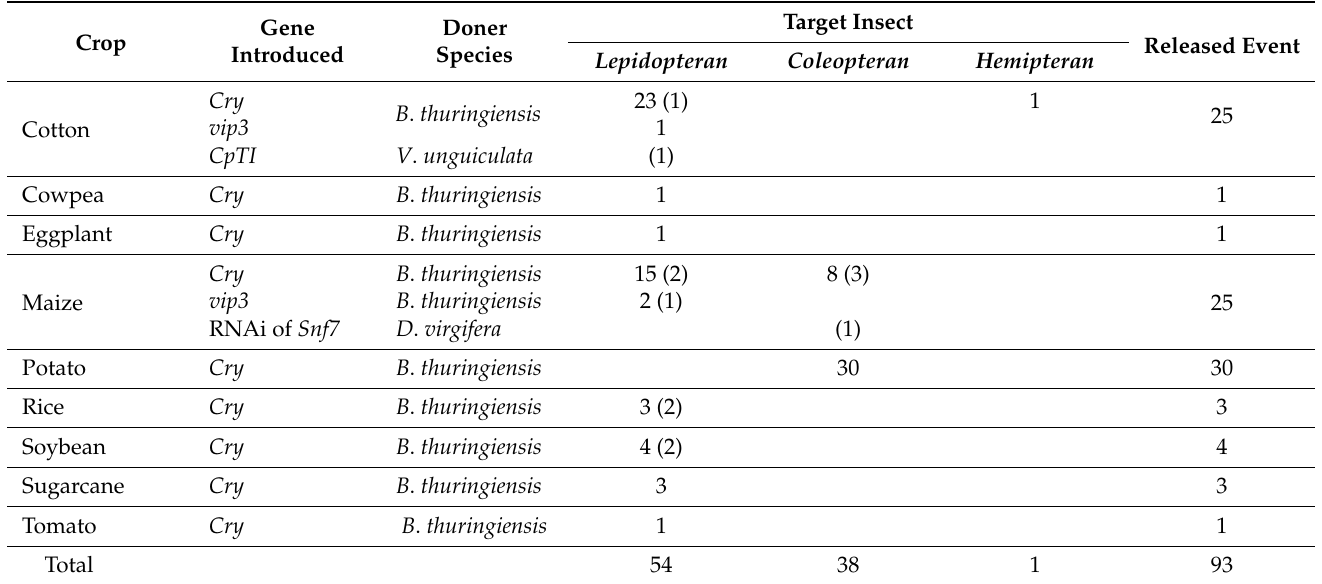
Table 1. Number of transgenic events of insect resistance authorized for cultivation and